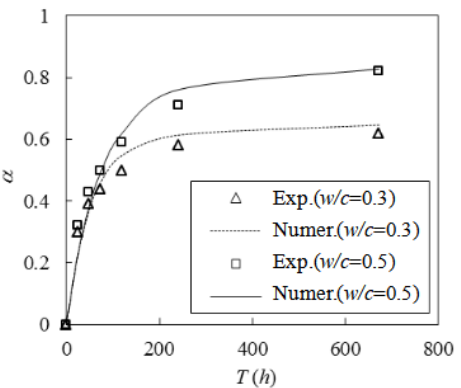
Figure 5. Comparison between the numerical results of hydration and experimental data [33].